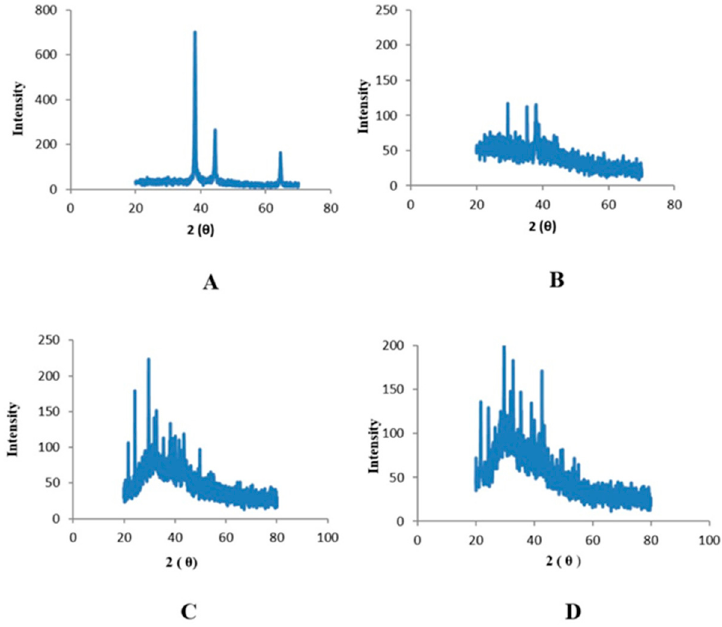
Figure 5. XRD peaks of zinc oxide nanoparticles of leaves: ( A ) n-hexane, ( B ) ethyl acetate, ( C ) methanol, and ( D ) aqueous extracts.